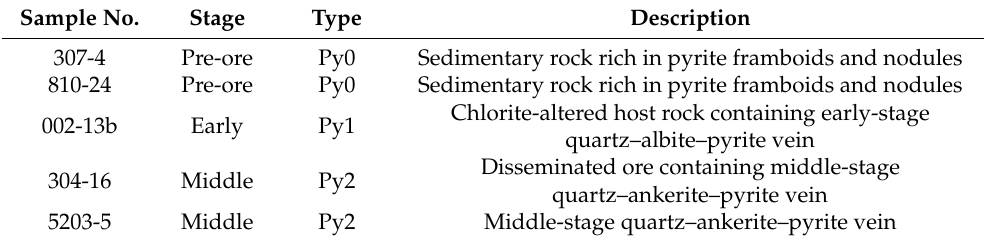
Table 1. Geology of samples from the Dunbasitao gold deposit analyzed using EPMA and LA-ICP-MS. Sample